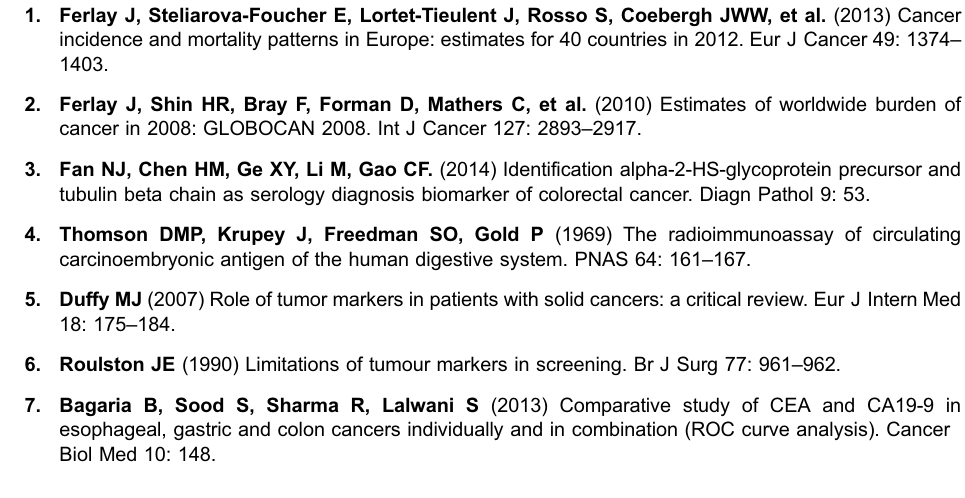
S1 Table. Clinical data of the colon cancer patients in DC-SIGN ELISA study. S2 Table. Clinical data of the colon cancer patients in DC-SIGNR ELISA study. S3 Table. Clinical data of the colon cancer patients whose serum were collected in immunohistochemical study. S4 Table. Clinical data of the colon cancer patients whose serum were collected in immunohistochemical